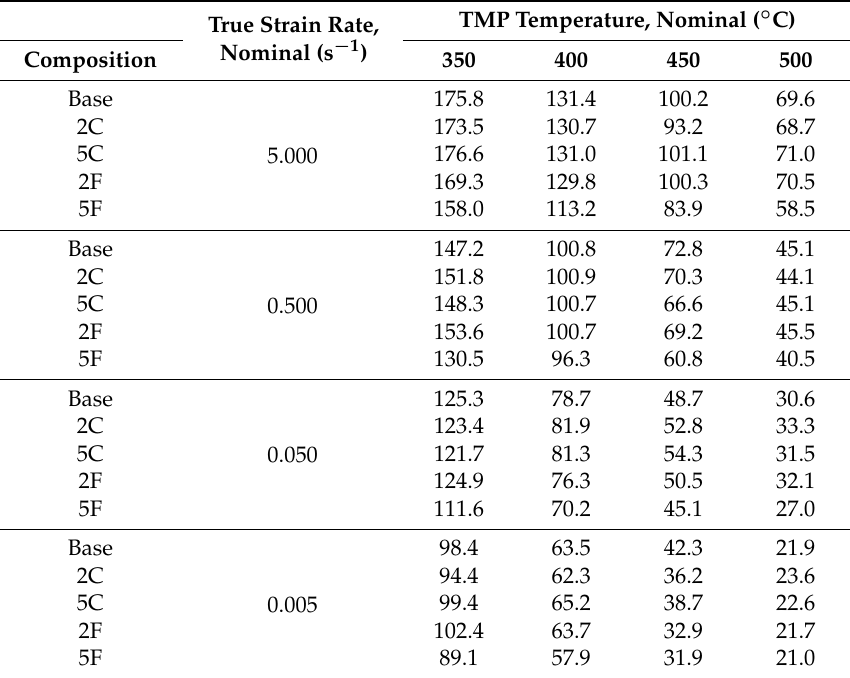
Figure 6. Flow stress (true stress—true strain) curves for alloy 2C developed during TMP at temperatures of 350 ◦ C to 500 ◦ C and strain rates of 5 s − 1 , 0.5 s − 1 , 0.05 s − 1 and 0.005 s − 1 . Table 4. Effects of TMP conditions and material composition on the peak flow stress.